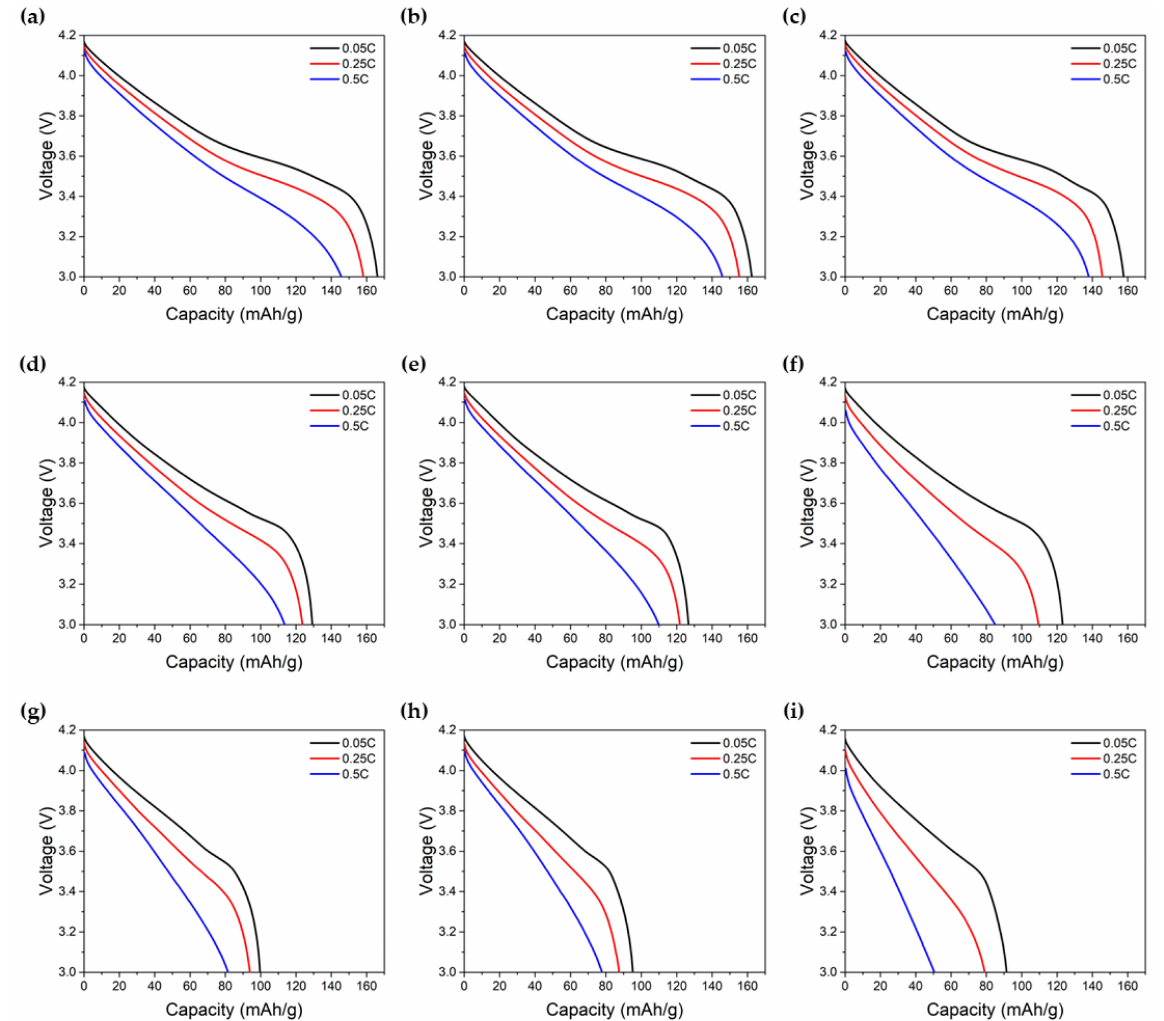
Figure 2. Experimental discharge curves of the 9 LIB test cells: ( a ) cell 1; ( b ) cell 2; ( c ) cell 3; ( d ) cell 4; ( e ) cell 5; ( f ) cell 6; ( g ) cell 7; ( h ) cell 8; and ( i ) cell 9. The degrees of the cyclable lithium loss and electrolyte depletion of cells 1–9 are given in Table